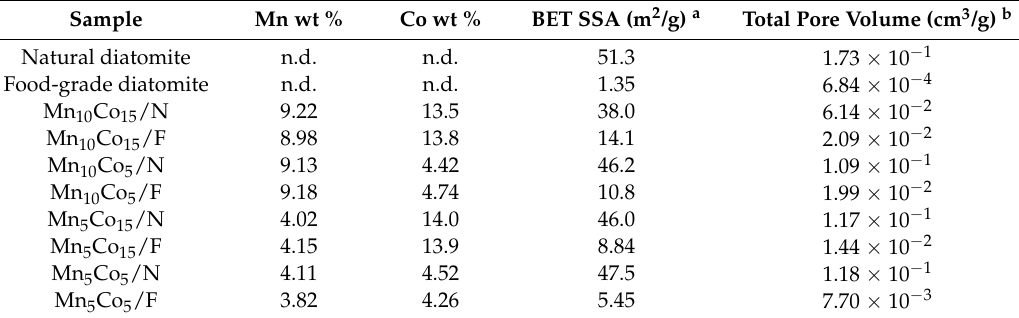
Table 1. SSA and total pore volume of the raw supports and examined samples.